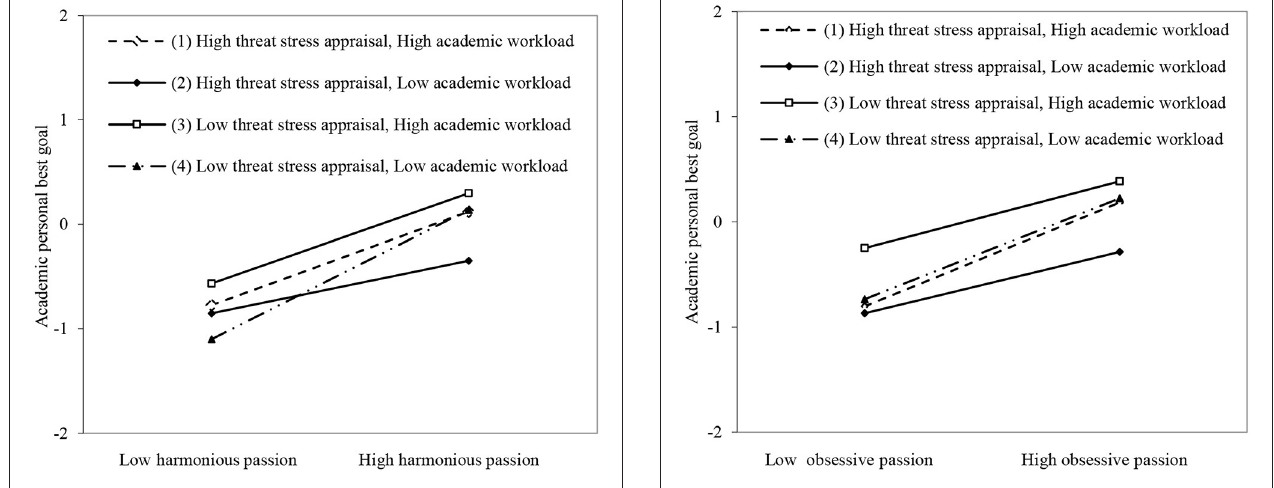
FIGURE 2 | The joint moderating effect of threat stress appraisal and academic workload on harmonious passion and academic personal best goal.